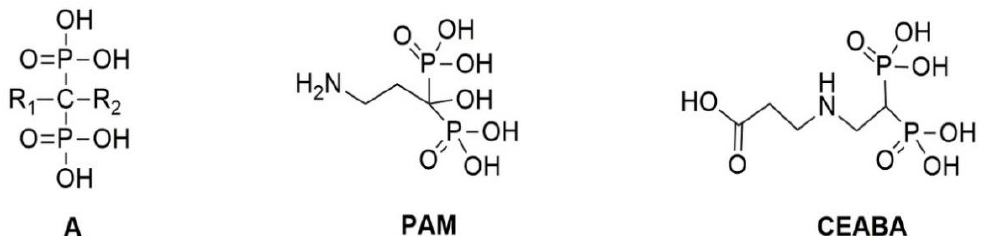
Figure 1. General structure of bisphosphonates (BPs) ( A ), pamidronic acid ( PAM ),